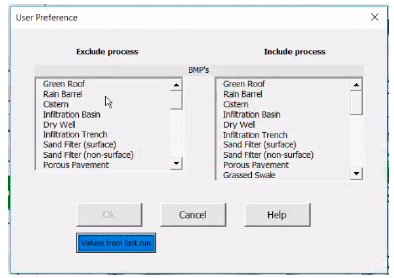
Figure A12. List of BMPs to include or exclude.